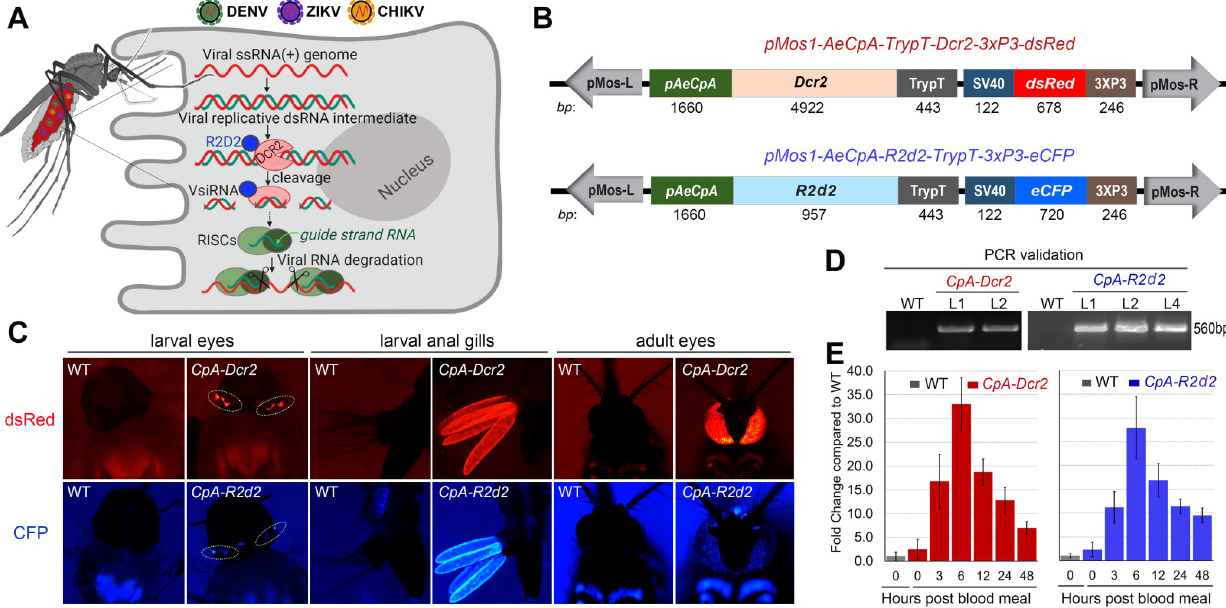
Fig 1. Generation of transgenic Aedes mosquitoes overexpressing Dcr2 and R2d2 under the control of the carboxypeptidase A promoter ( pAeCpA or CpA ). ( A ) Schematic presentation of the viruses in the blood bolus of the mosquitoes after an infectious blood meal and the mechanisms undergirding the antiviral siRNA pathway. In the cytoplasm of mosquito midgut epithelium cells, a viral replicative dsRNA intermediate is recognized by DCR2 in complex with R2D2, followed by cleavage of the viral dsRNA into 21-nt siRNAs by AGO2 in the RISC. The illustration was created with BioRender.com. ( B ) Schematic presentation of the 2 Mos1-mariner ( pMos1 ) transformation plasmids used to generate the CpA-Dcr2 and CpA-R2d2 lines. pMosL , pMosR : Mos1-mariner left and right arms. 3xP3-eCFP and 3xP3-dsRed are used for eye-specific promoter-driven expression of either eCFP (blue) or dsRed (red) as eye markers for sorting the transgenic mosquitoes. AeCpA promoter: carboxypeptidase A promoter; Dcr2 or R2d2 : Dcr2 or R2D2 gene coding sequences; TrypT: trypsin terminator sequence. ( C ) Fluorescent images of larvae and adults of the CpA-Dcr2 and CpA-R2d2 transgenic mosquitoes. ( D ) Confirmation of transgenes through PCR using the primers listed in S1 Table. ( E ) Transcript abundance of transgenes ( Dcr2 in red and R2d2 in blue) in the midgut of CpA-Dcr2 and CpA-R2d2 lines from before the blood meal (0 h) to 48 h PBM. Each bar represents the relative-fold change of the corresponding gene assayed through qRT-PCR in CpA-Dcr2 or CpA-R2D2 , compared between transgenic lines and WT mosquitoes. The rps17 gene was used to normalize the cDNA template, and error bars indicate the S.E. of the mean. dsRNA, double-stranded RNA; PBM, post-blood meal; qRT-PCR, quantitative real-time PCR; siRNA, small interfering RNA; WT, wild type.